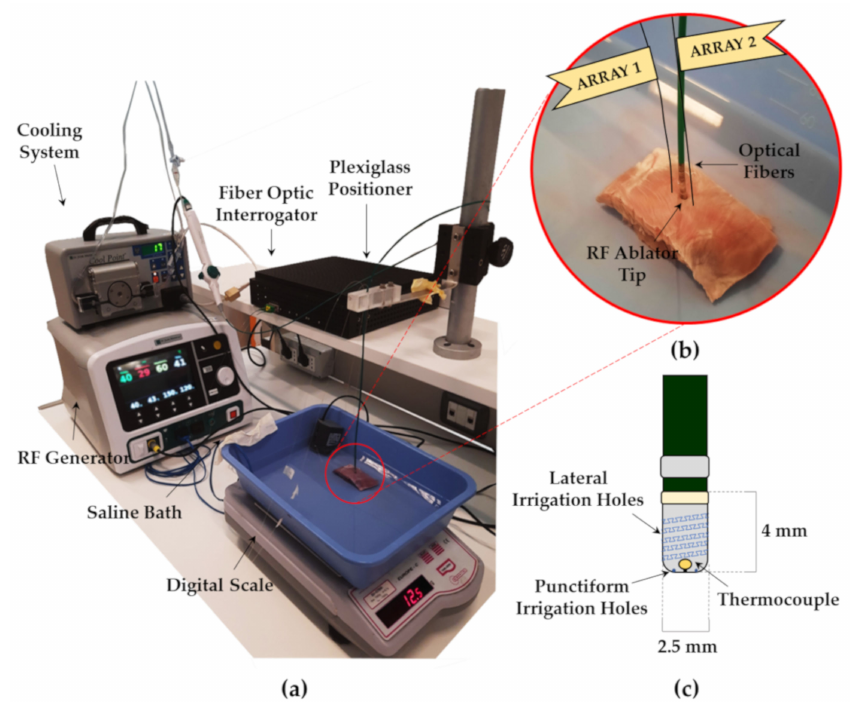
Figure 3. The experimental setup used to perform radiofrequency ablation (RFA) of the myocardial tissue. ( a ) Photo of the setup; ( b ) a zoom-in on the myocardial specimen showing the optical fibers and the RF ablator placement; ( c ) a graphic representation of the RF catheter showing the antenna tip,